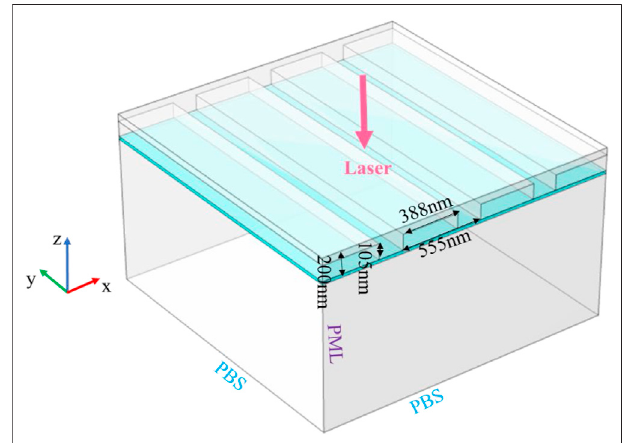
FIGURE 1 | Electric fi eld model of the